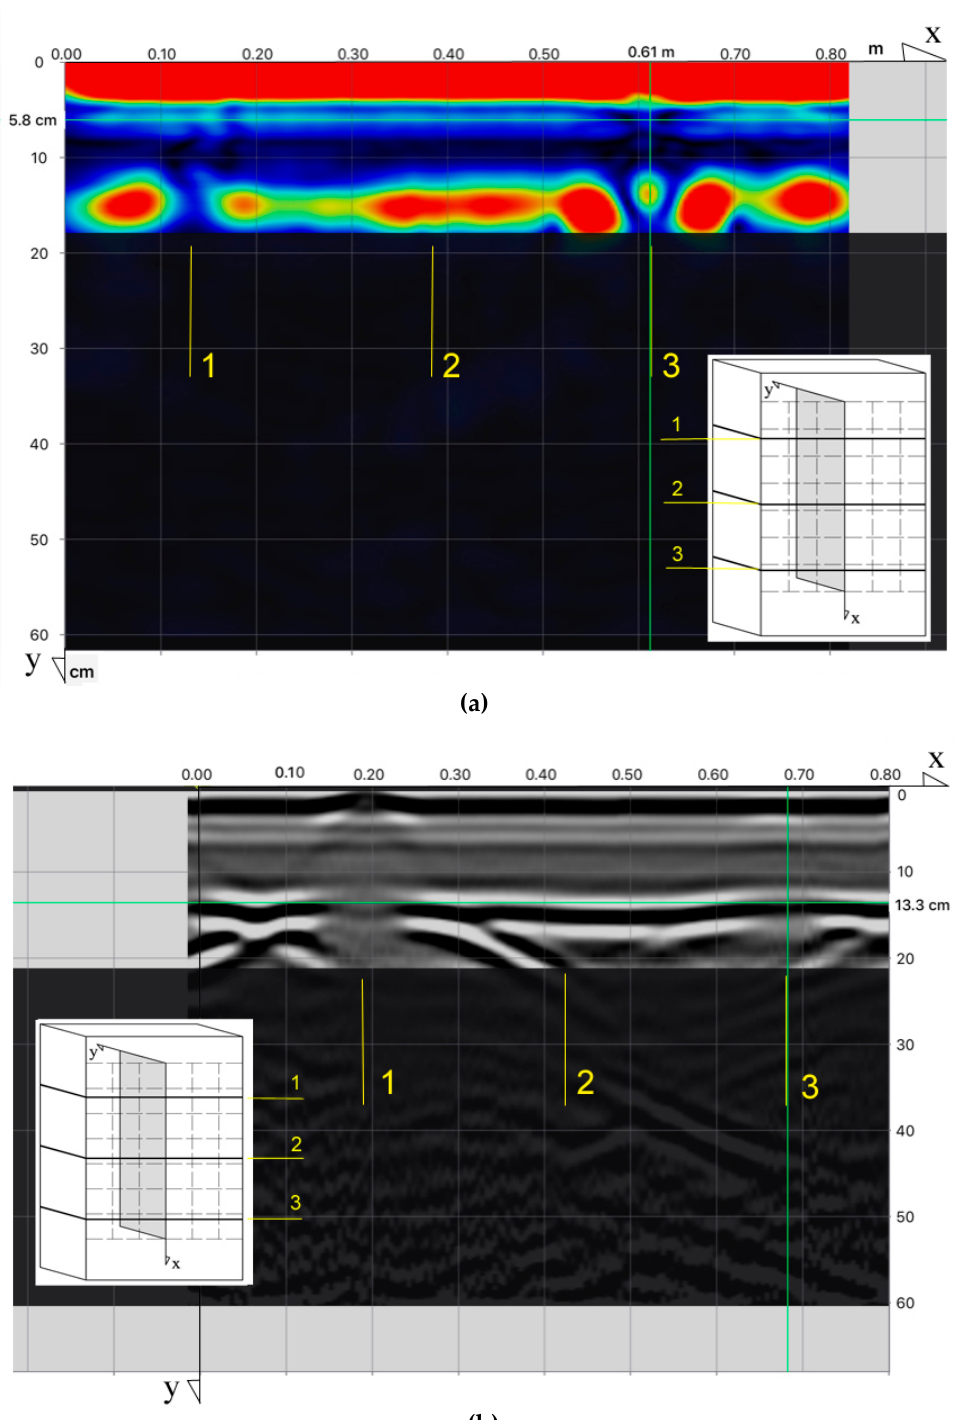
Figure 7. B-scans (sectional view of the element) of the masonry specimen No. 1 from tests performed with: ( a ) ultrasonic tomography, ( b ) GPR scanner, 1 —location of steel mesh with a diameter of 1.2 mm, 2 — location of fibreglass mesh (size 10 × 12 mm), 3 — location of basalt mesh (size 30 × 30 mm).